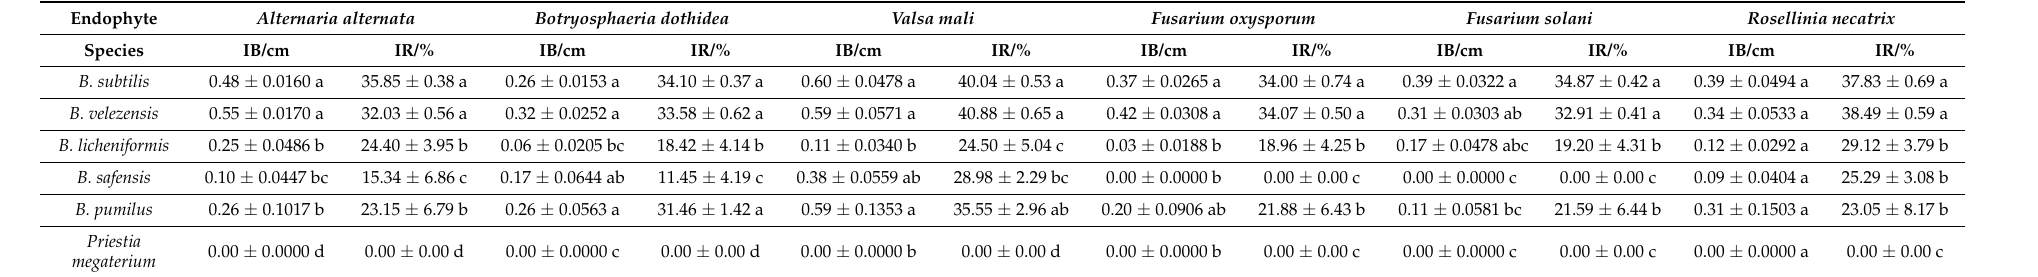
Table 3. Antagonism of apple endophytic bacteria against apple fungal